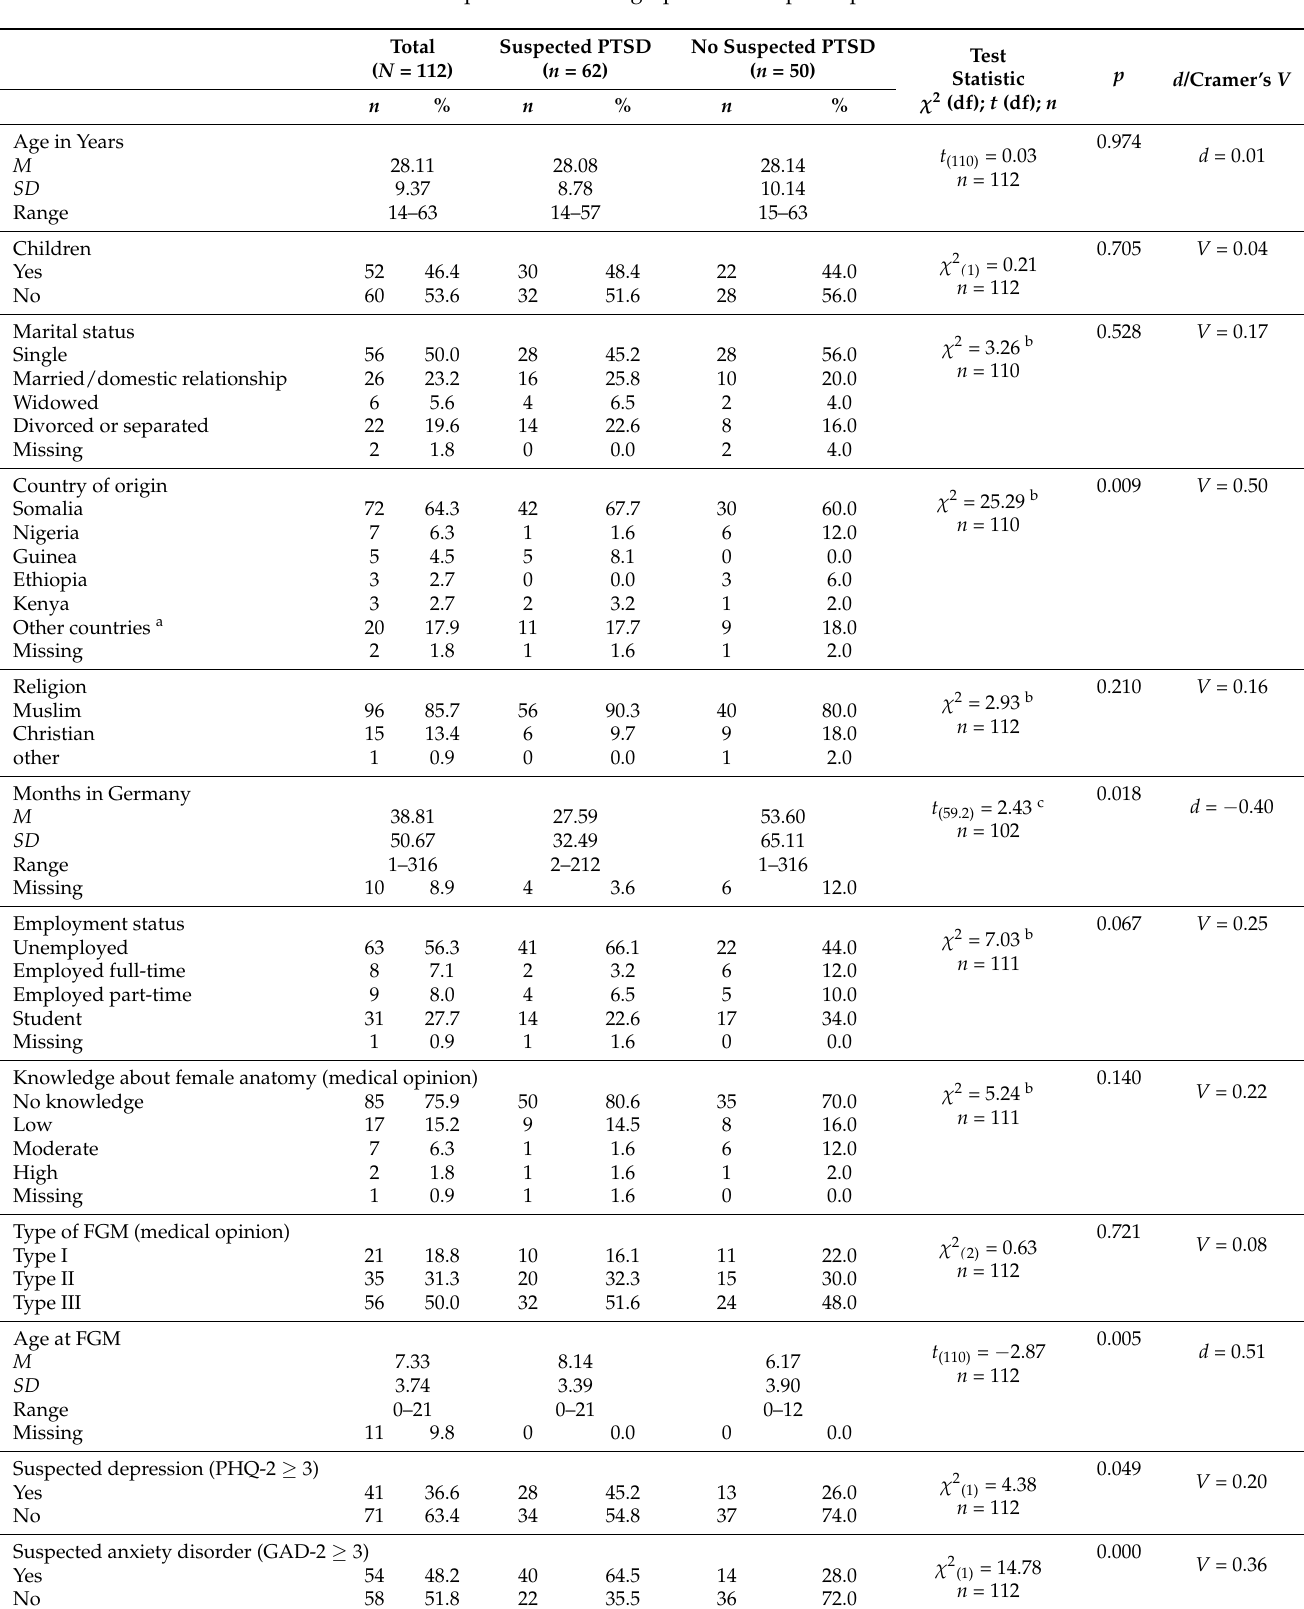
Table 1. Excerpt of socio-demographic data of